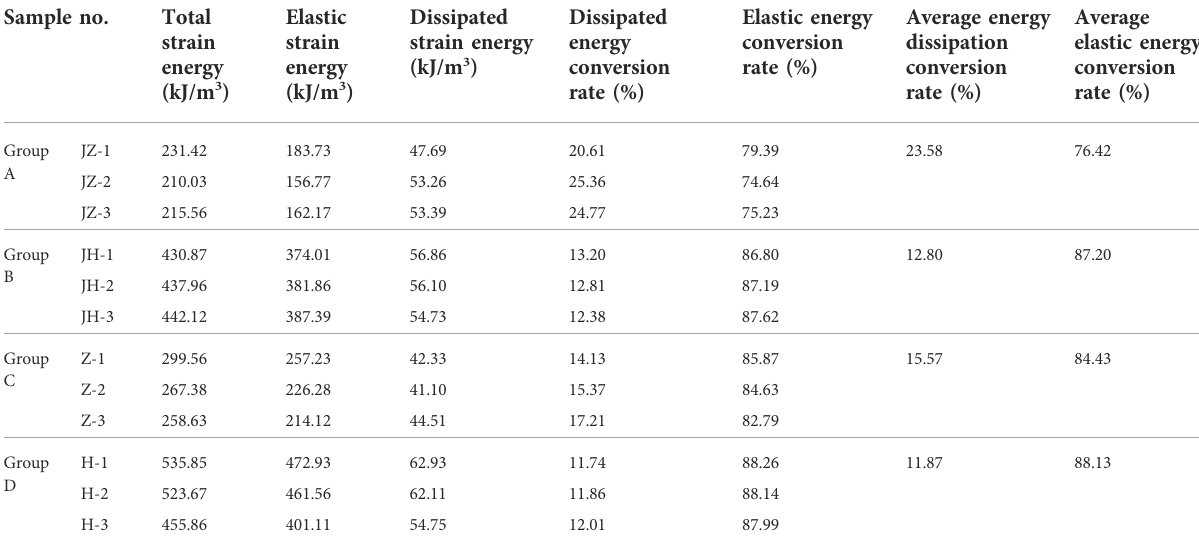
TABLE 3 Characteristic parameters of compression energy. Sample